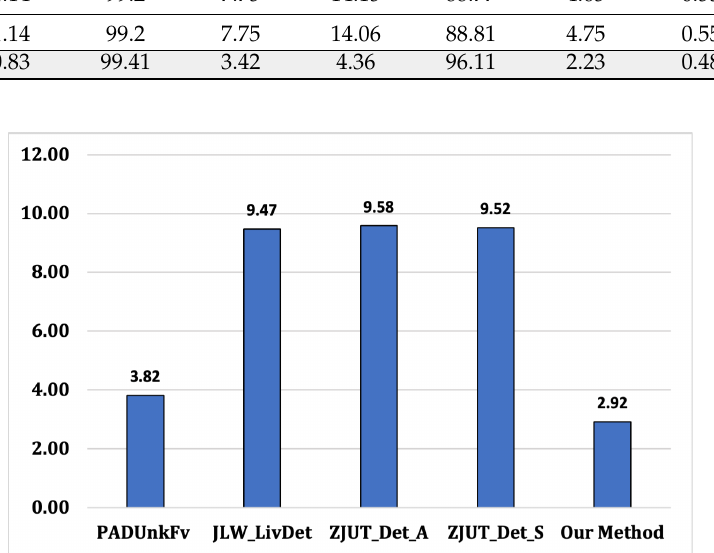
Figure 4. PAD methods: The mean ACC differences between